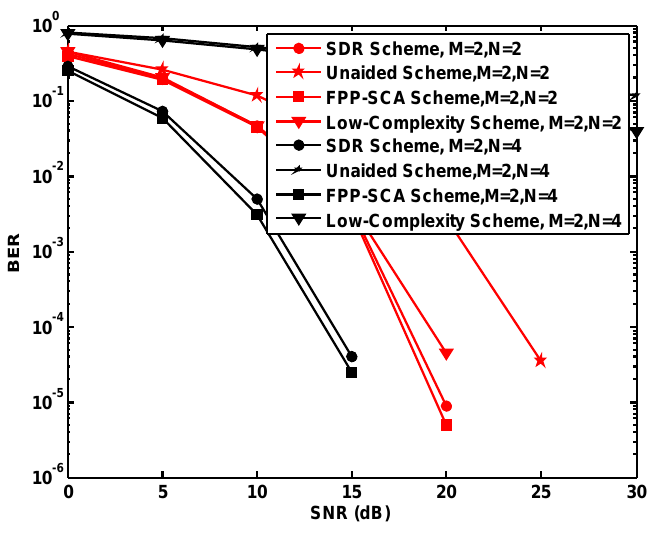
Figure 4. BER versus SNR for 50 iterations. Table 2. The BER performance for different schemes when M = N = 2.